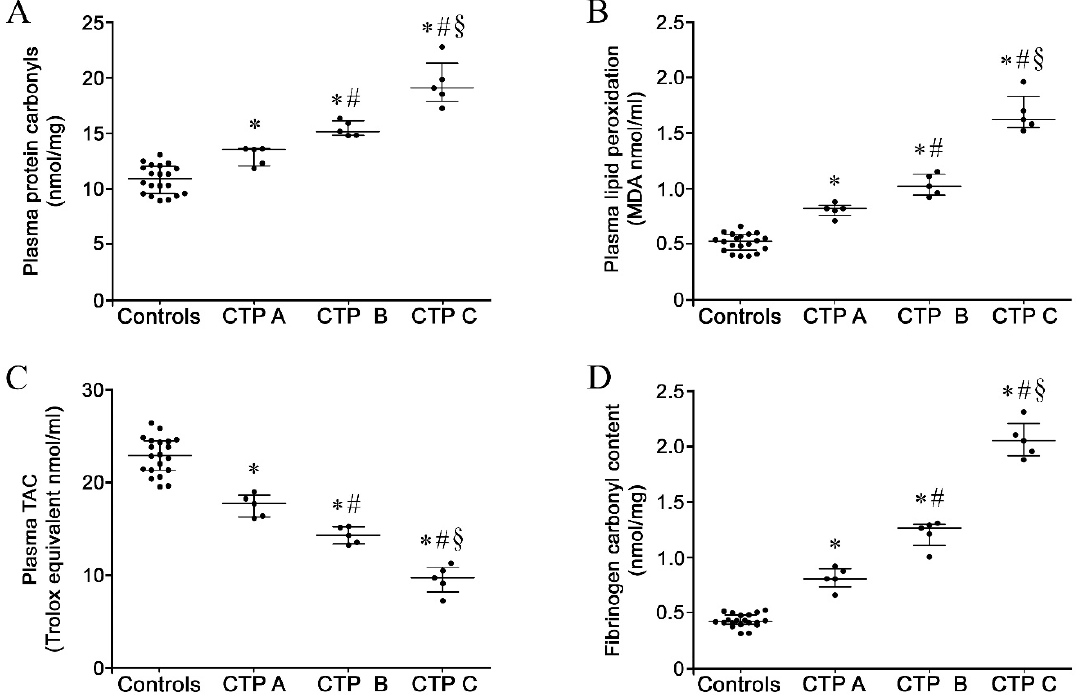
Figure 1. Plasma protein carbonyl content ( A ), plasma lipid peroxidation ( B ), plasma total antioxidant capacity ( C ) and fibrinogen oxidation in purified fibrinogen fractions ( D ) in patients with liver cirrhosis at different disease severity ( n = 5 for each Child–Turcotte–Pugh category) and controls ( n = 20). All experiments were performed in triplicate. Values are represented as median with interquartile range. *Significant difference vs. controls at the P < 0.05 level. # Significant difference vs. CTP A at the P < 0.05 level. § Significant difference vs. CTP B at the p < 0.05 level.